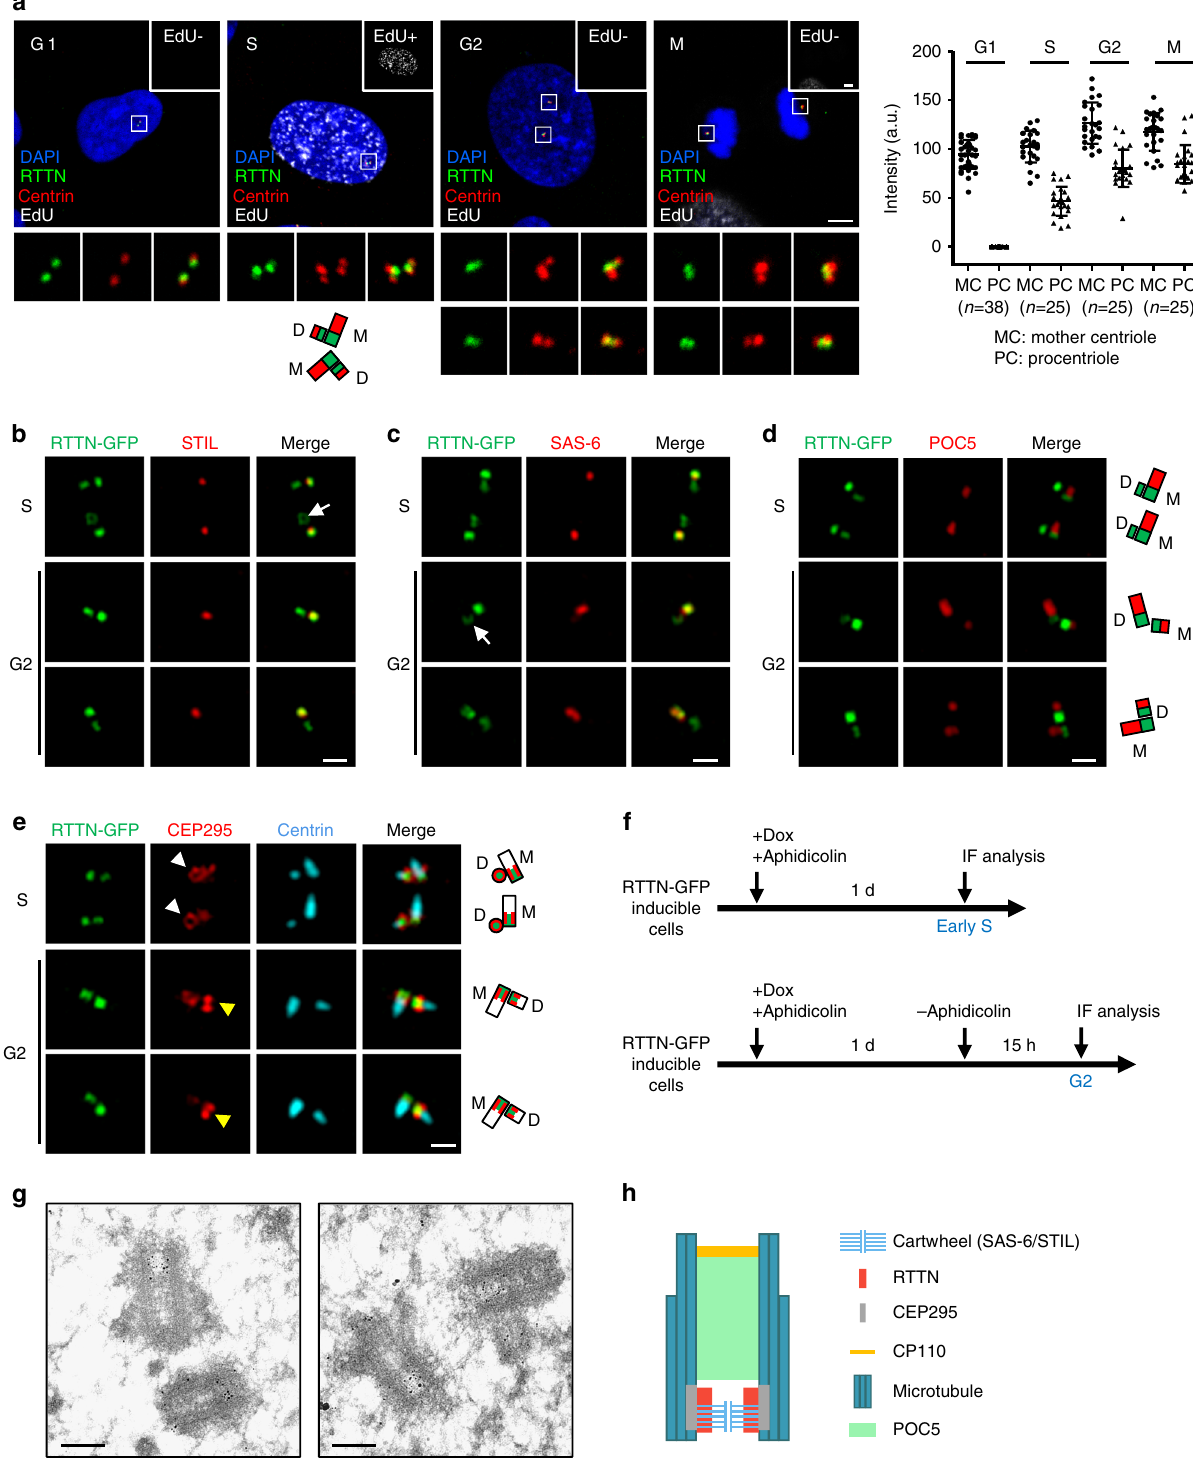
Fig. 4 Super-resolution (3D-SIM) and immunogold electron microscopic analysis of the localization of RTTN during centriole biogenesis. a The subcellular localization of RTTN during the cell cycle. U2OS cells at different cell cycle stages were subjected to EdU labeling ( white ) and immuno fl uorescence staining using antibodies against RTTN ( green ) and centrin ( red ). EdU-labeled nuclei (EdU+) indicate cells at S phase. DNA was counterstained with DAPI ( blue ). The fl uorescence intensity of RTTN at centrioles was quanti fi ed by ZEN software. b – f RTTN-GFP doxycycline (Dox)-inducible cells were treated as described in f , and stained with antibodies against STIL b , SAS-6 c , POC5 d , CEP295 e , and centrin e . The fl uorescence images were analyzed by 3D-SIM. M, mother centriole; D, daughter centriole. g Immunogold EM analysis of RTTN localization. h A schematic showing the localization of RTTN relative to those of other centriolar proteins at a centriole. Scale bar , 5 μ m in a ; Scale bar , 0.5 μ m in b – e ; Scale bar , 200 nm in